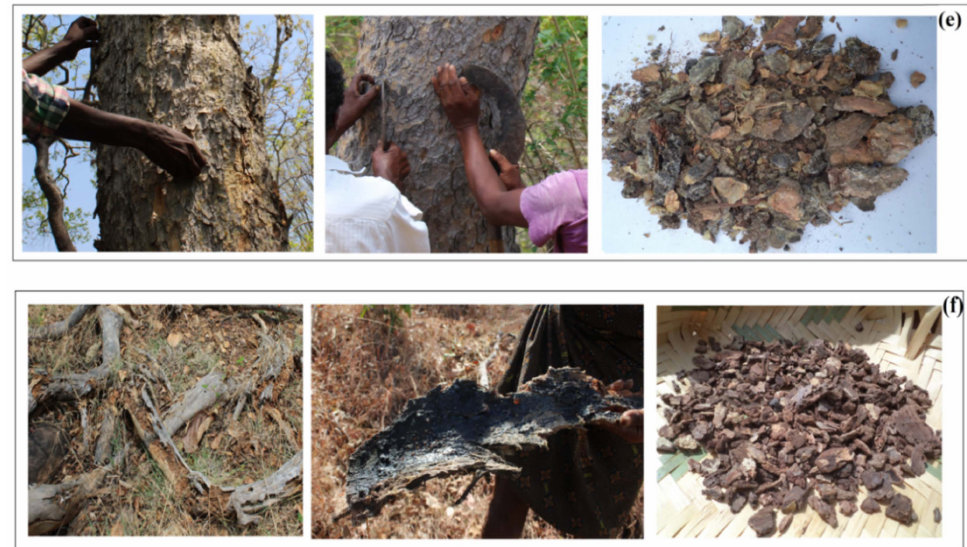
Figure 4. ( a ) pure gum-resin harvesting, ( b ) gum-resin stuck to the bark, ( c ) soil mixed gum-resin, ( d ) longhorn beetle-infested gum-resin, ( e ) bark scales, and ( f )